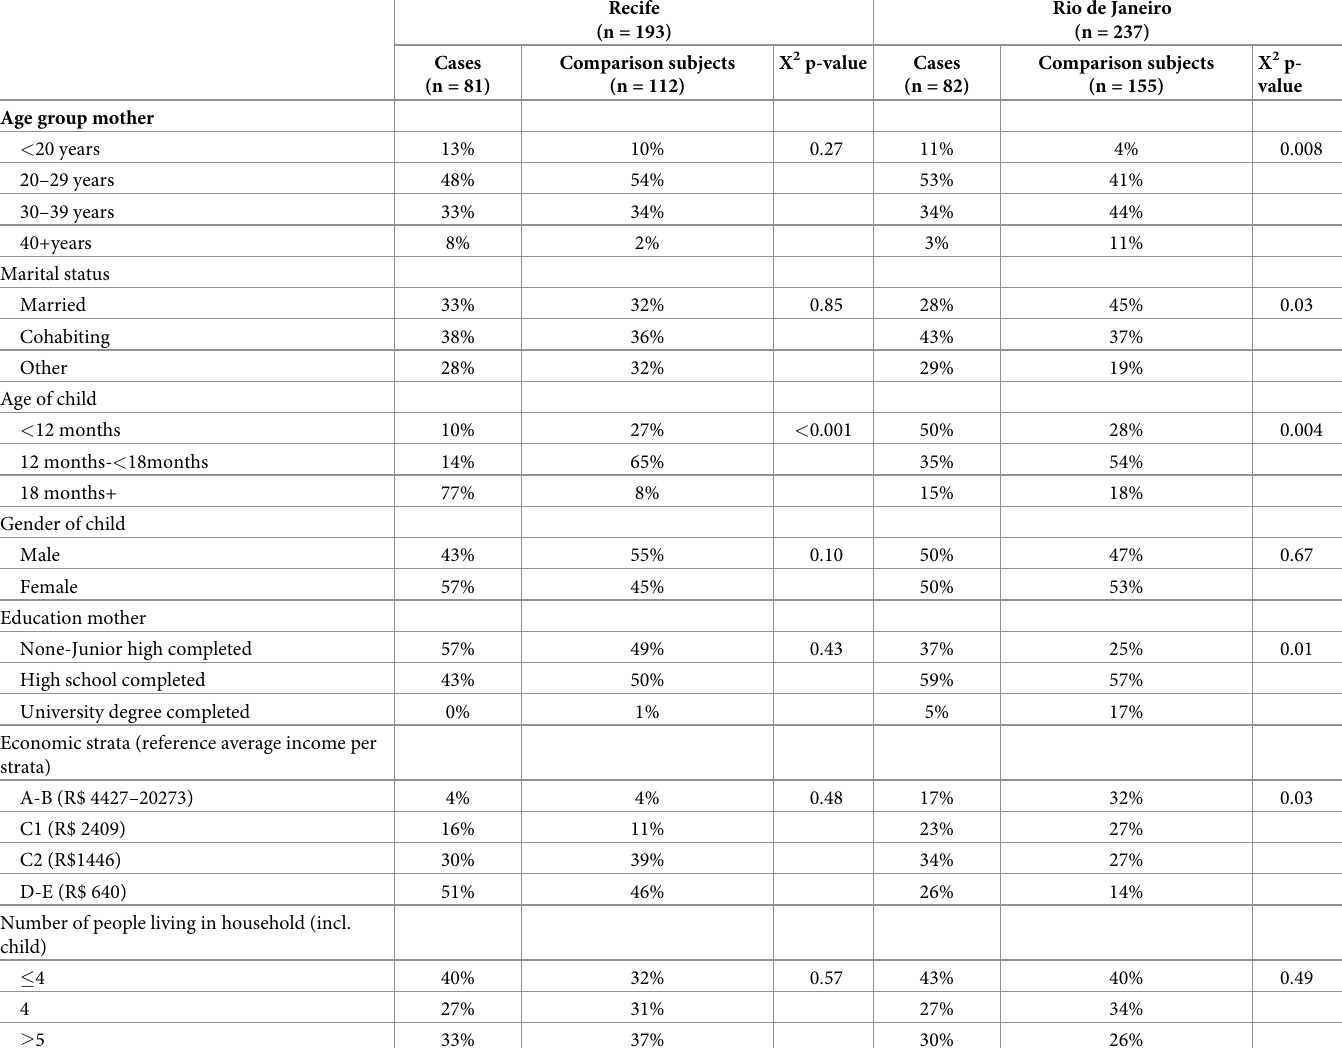
Table 1. Baseline characteristics of mothers with a child with microcephaly and comparison